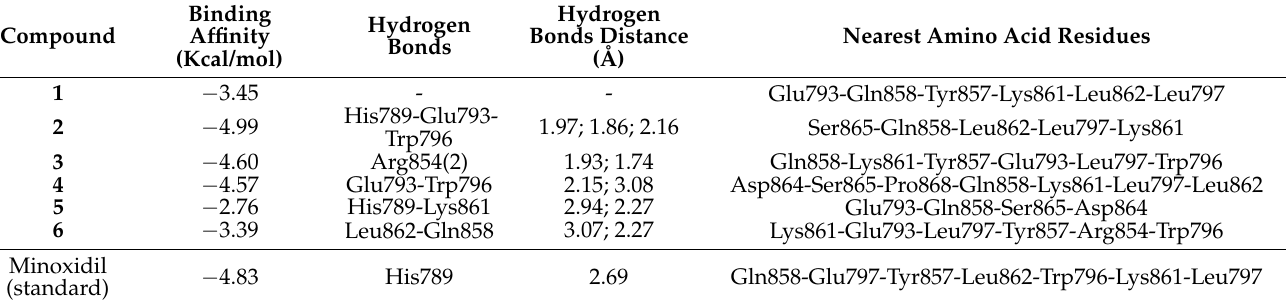
Table 7. Molecular docking simulation results.